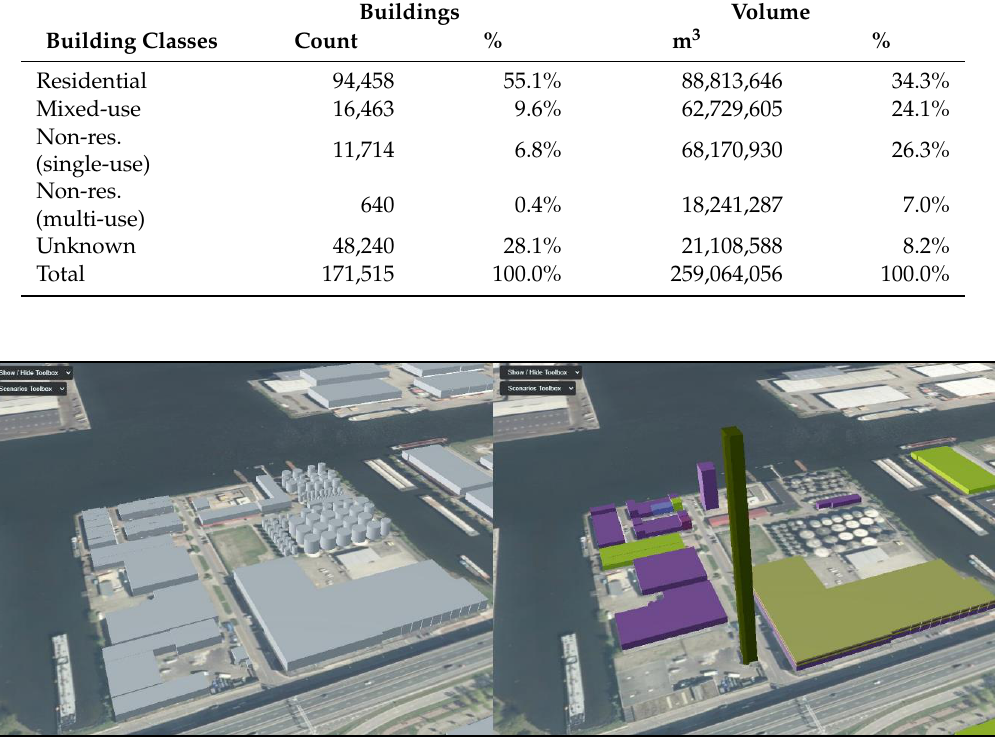
Figure 14. ( Left ) The volumetric city model and ( right ) the corresponding UsageZones. The net floor area (and derived volume) of the tall UsageZone is due to the value comprising also the net floor area of the nearby buildings, for which no Usagezone was generated.